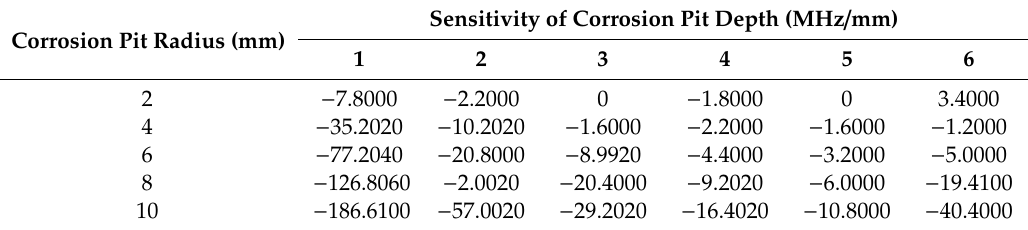
Figure 12. Influence of the volumetric corrosion pit depth on resonant frequency.